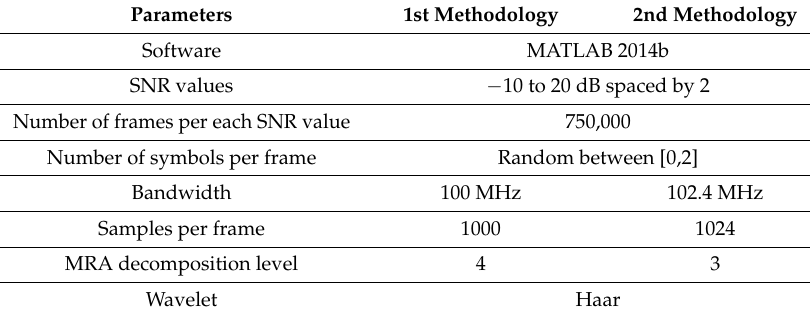
Figure 13. Scheme of the global simulation. Table 2. Simulation parameters.